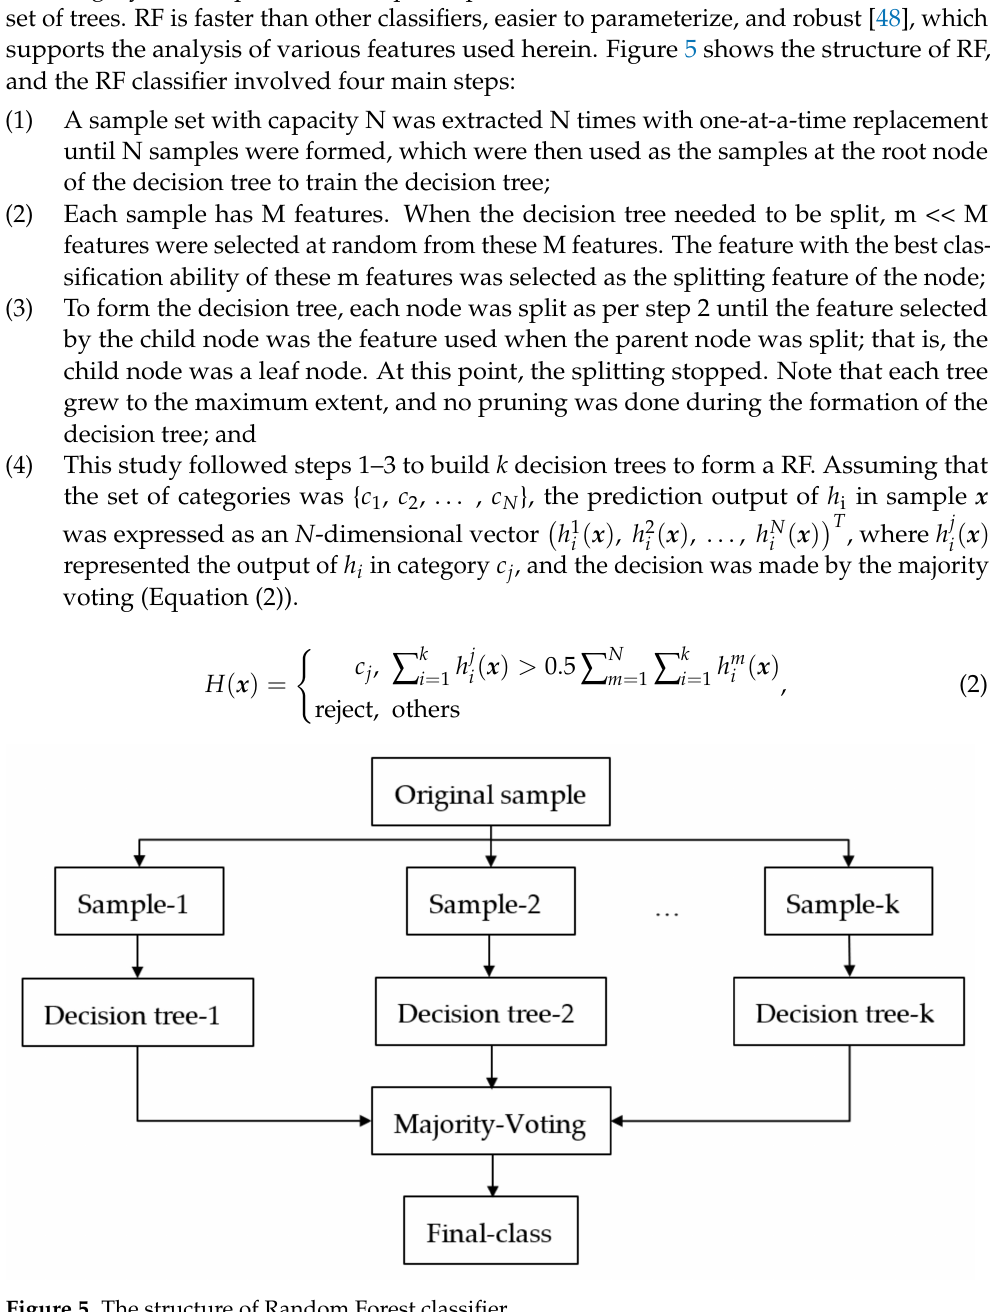
Figure 5. The structure of Random Forest